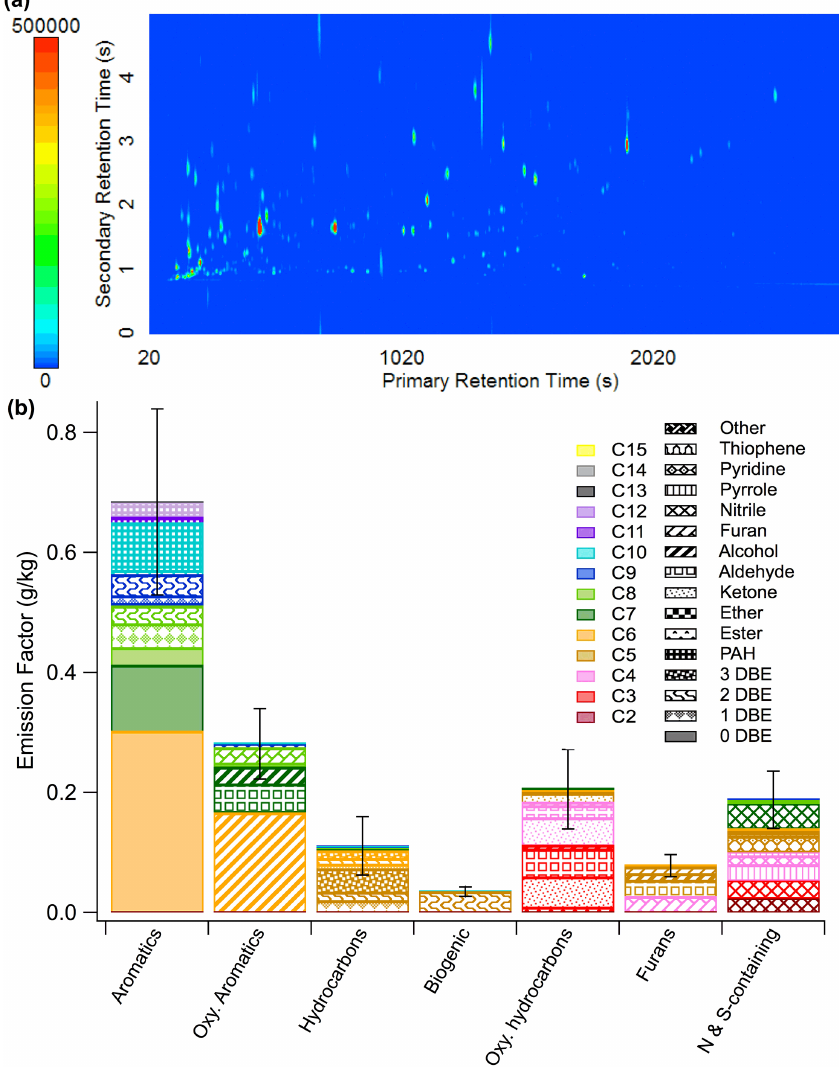
Figure 3. As in Fig. 1, for a giant cutgrass